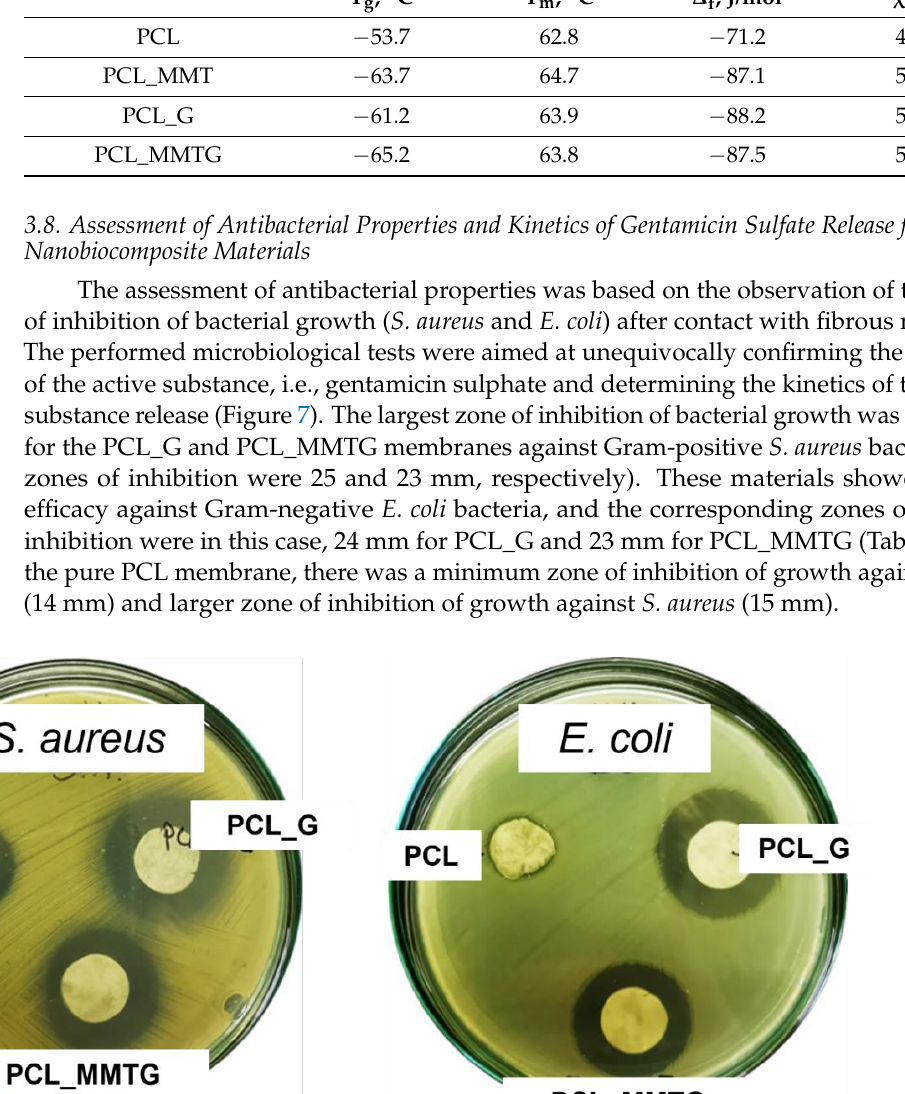
Table 5. Summary of DSC results for the tested PCL fibrous material and PCL-based nanobiocomposites. T g , ◦ C T m , ◦ C PCL